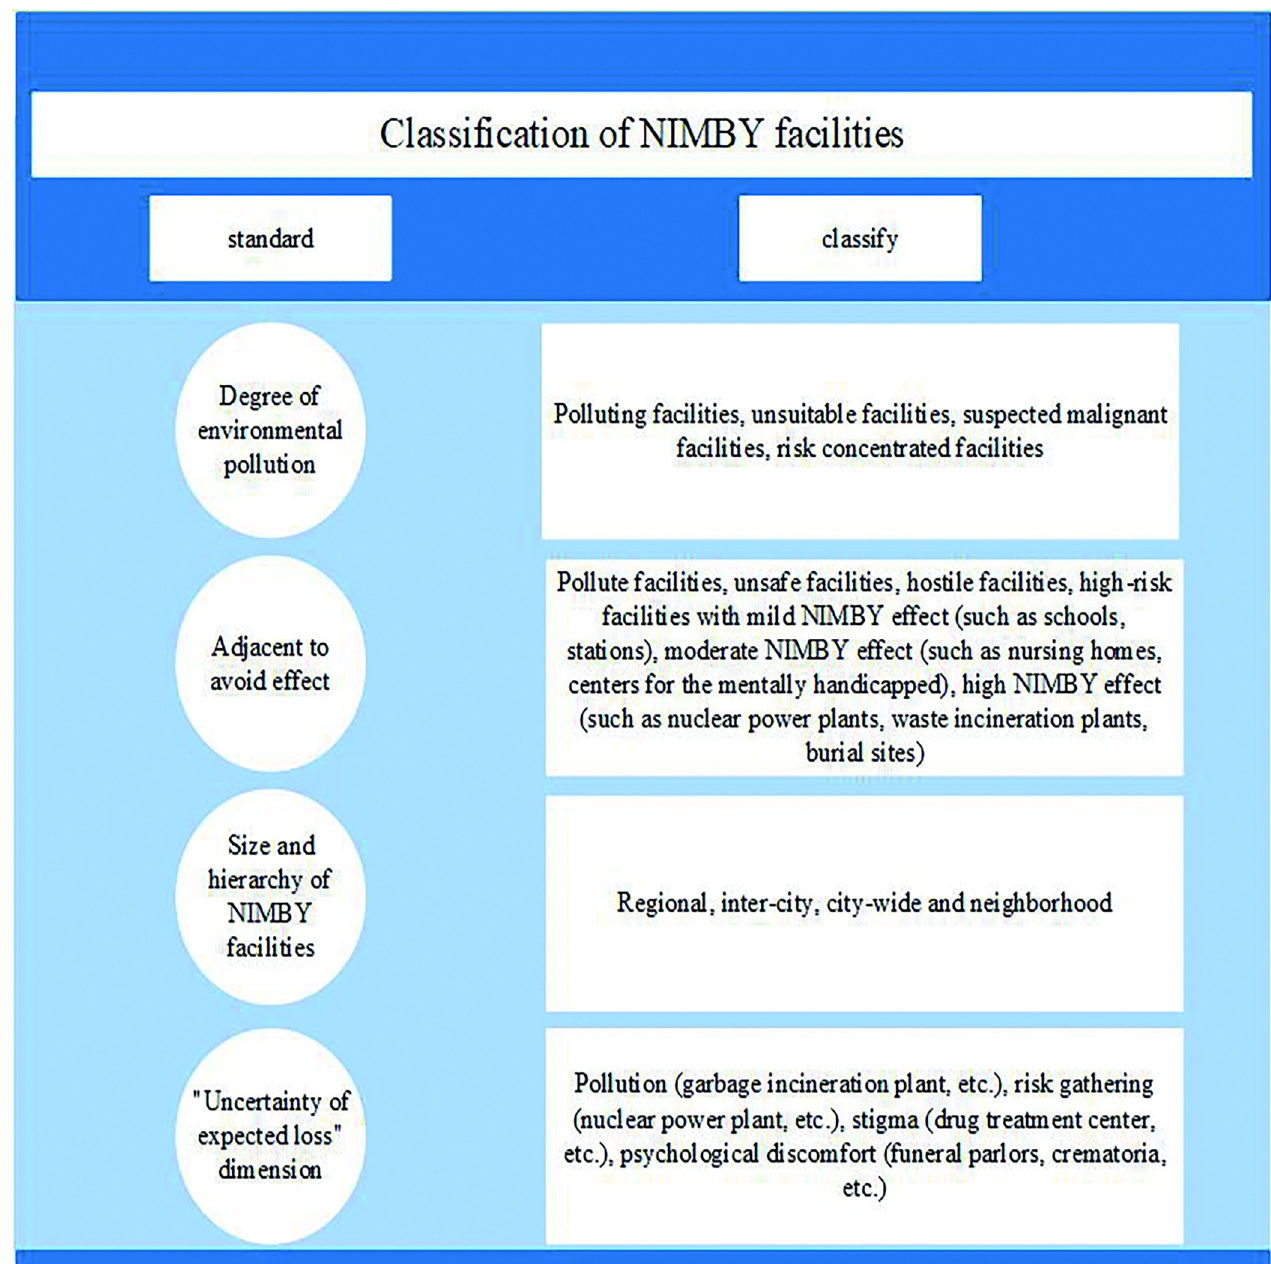
Fig 1. Classification of NIMBY facilities. The column on the left of the picture shows the criteria for the classification of NIMBY facilities. The column on the right of the picture is a detailed description of the classification of NIMBY facilities.